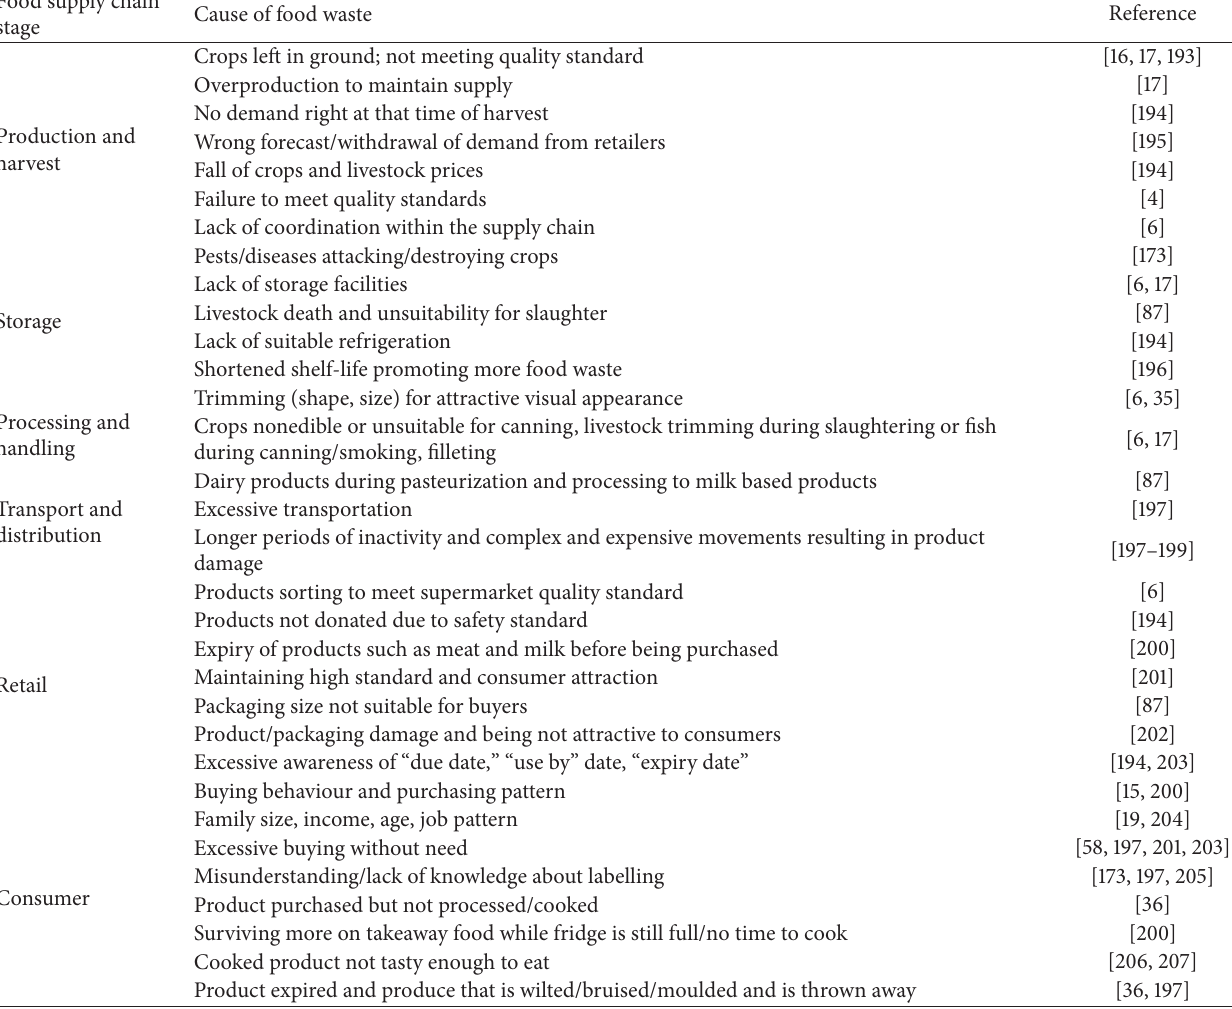
Table 2: Food wastes produced in the food supply chain as reported in the